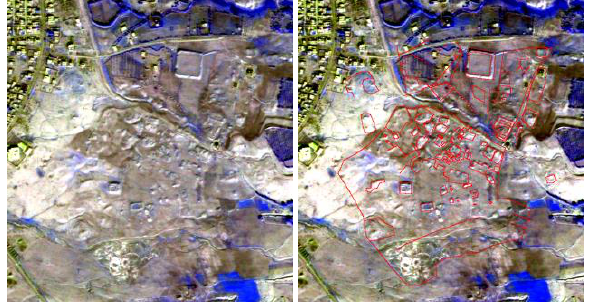
Figure 13 - Makhmúr al-Qadima - a RGNIR synthesis of the FORMOSAT-2 images (acquired on 2 11. 2014) with an overlaid objects of interest on the left